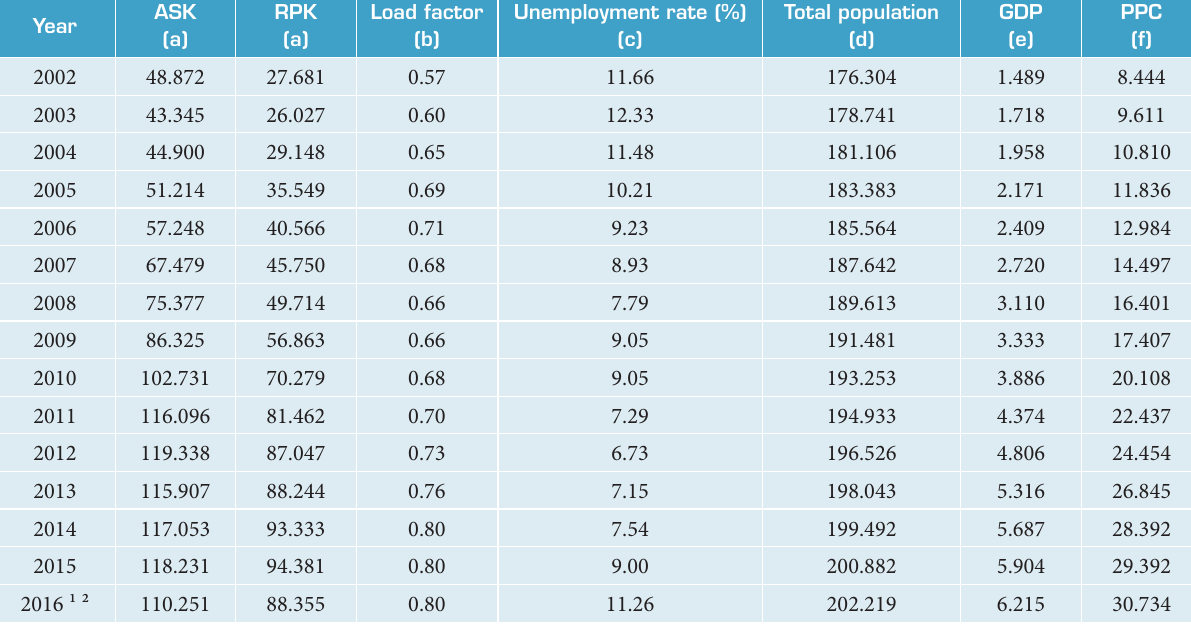
Table 2. Air transport services supply and demand in the Brazilian domestic market and economic and demographic